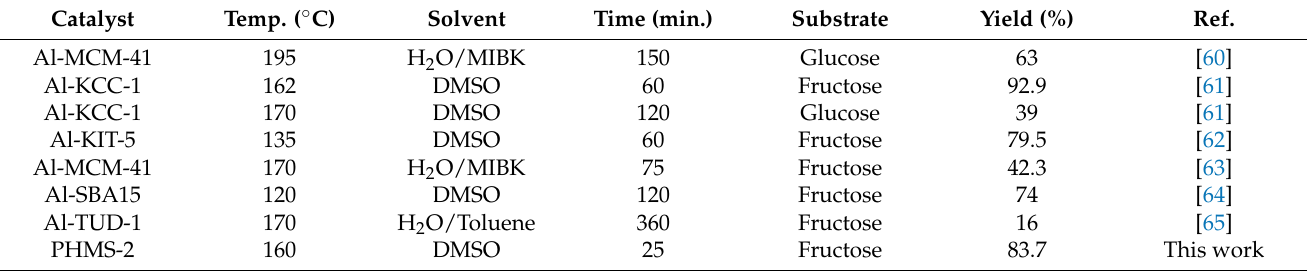
Table 2. Comparative study of catalytic efficiency in HMF conversion reaction between PHMS-2 and other Al-grafted nanoporous silica